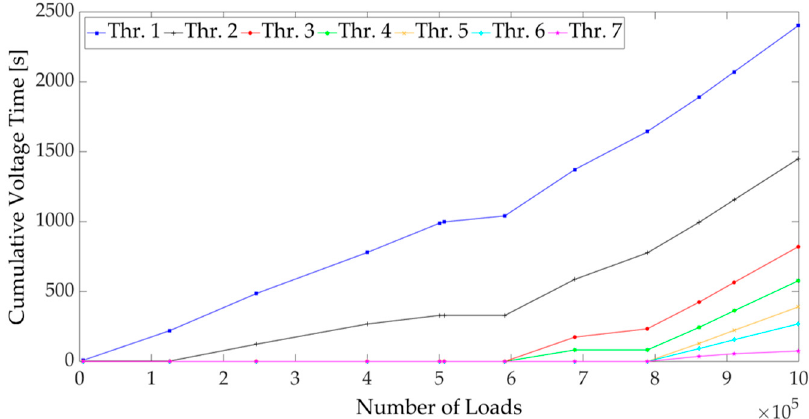
Figure 11. Cumulative voltage time for H3.